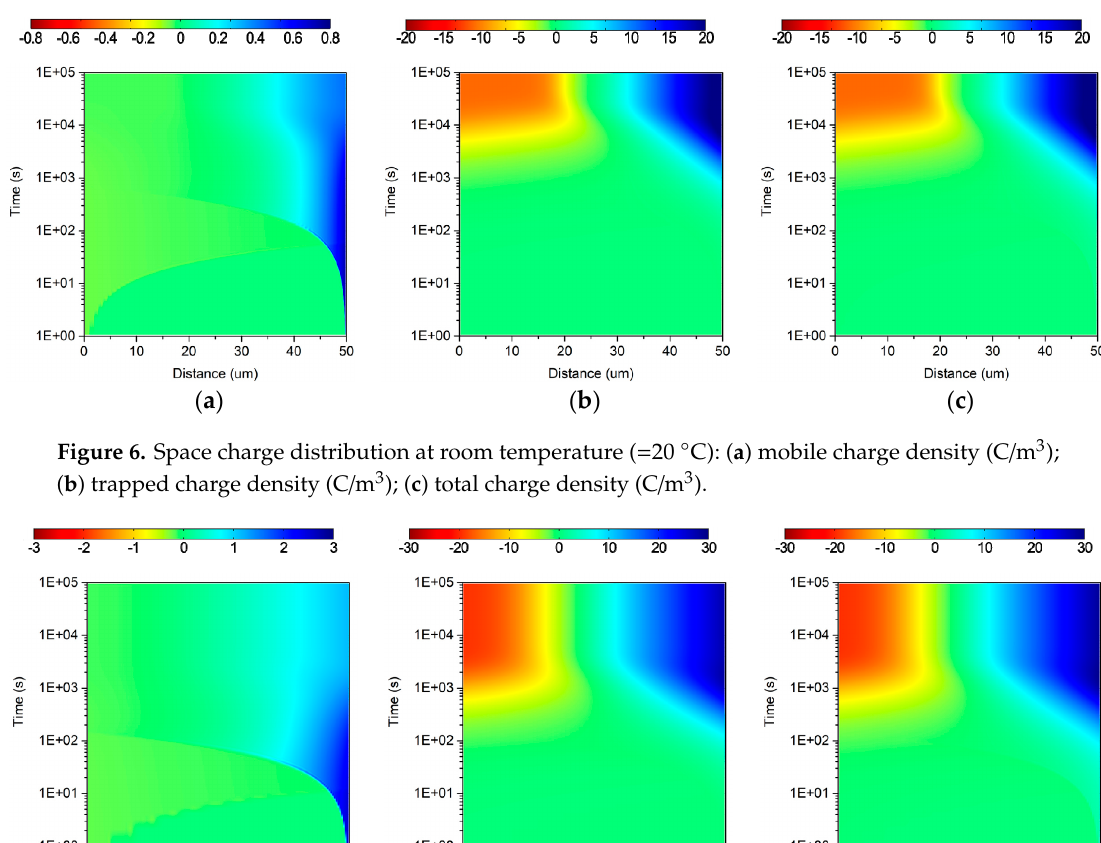
Figure 7. Space charge distribution at 40 °C: (a) mobile charge density (C/m 3 ); (b) trapped charge density (C/m 3 ); (c) total charge density (C/m 3 ).